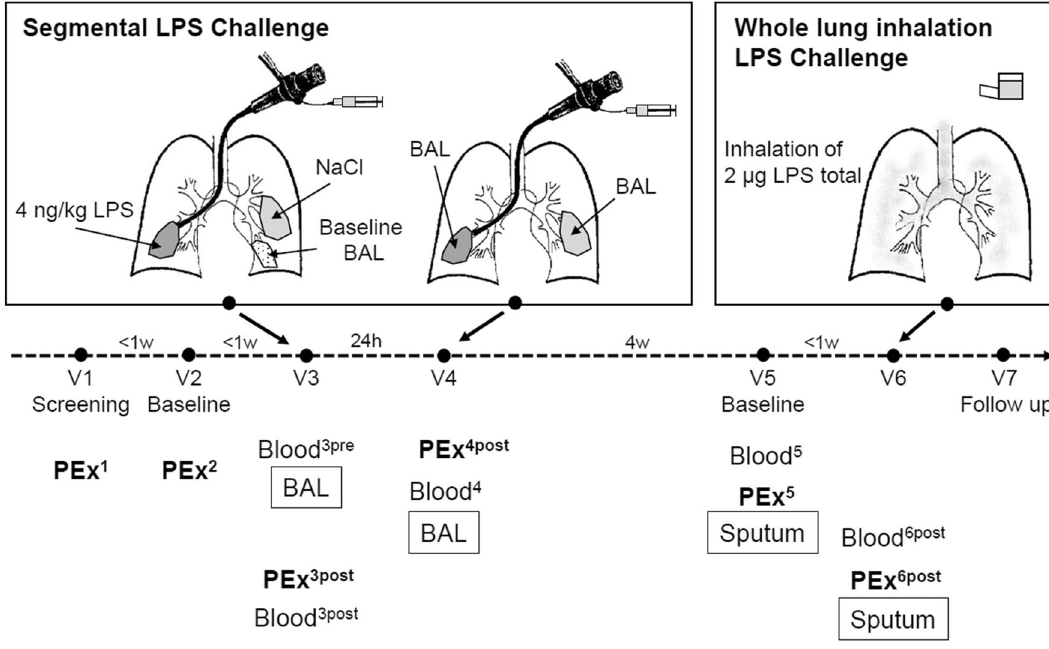
Figure 1. Study design. The study was designed to test the ability of novel noninvasive methods to detect airway inflammation. Here we focus on exhaled breath particles (PEx). BAL bronchoalveolar lavage, V visit (index pre: refers to samples taken before a challenge, post: refers to samples taken after a challenge), NaCl isotonic saline solution, LPS endotoxin, w week, h hours. PEx samples were collected on V3 in the afternoon 5 h after the segmental challenge. On V4 PEx were sampled prior to the BAL procedure 21 h after the LPS challenge. On visit 5 and 6 PEx were collected before the sputum induction. On V6 this was done 5 h following the inhalation LPS